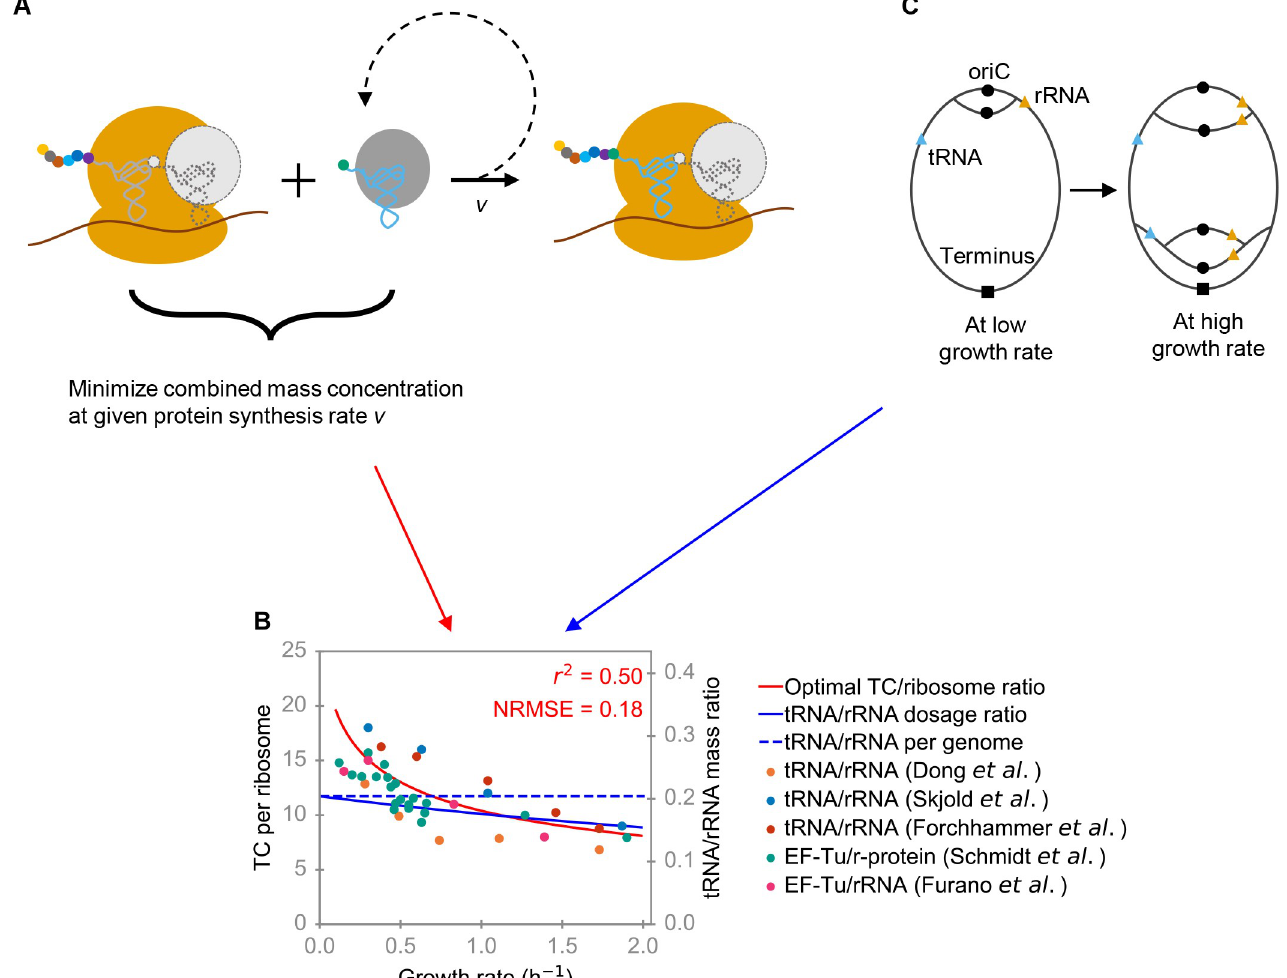
Fig 1. The RNA growth law and its implementation through gene positions. (A) Coarse-grained protein translation model, following Michaelis-Menten kinetics with the active ribosome as catalyst and TC as substrate. The optimal TC/ribosome expression ratio is derived by minimizing the combined mass concentration of ribosome and TC at the given protein synthesis rate v . (B) Different experimental estimates of TC/ribosome expression ratios in E . coli (points, colors indicate the data source) are consistent with the optimal ratio according to Eq (1) (red line) (Pearson’s r 2 = 0.50; NRMSE = 0.18). The dashed blue line indicates the genomic tRNA/rRNA ratio, the solid blue line indicates the tRNA/rRNA gene dosage ratio estimated from Eq (21). (C) A schematic diagram showing the dosage ratio of two genes as a function of growth rate. If rRNA genes are located on average closer to oriC than tRNA genes–which is the case in E . coli– then the dosage of rRNA genes will increase faster with increasing growth rate than that of the tRNA genes; consequently, the tRNA/rRNA gene dosage ratio becomes a decreasing function of growth rate (solid blue curve in panel B).